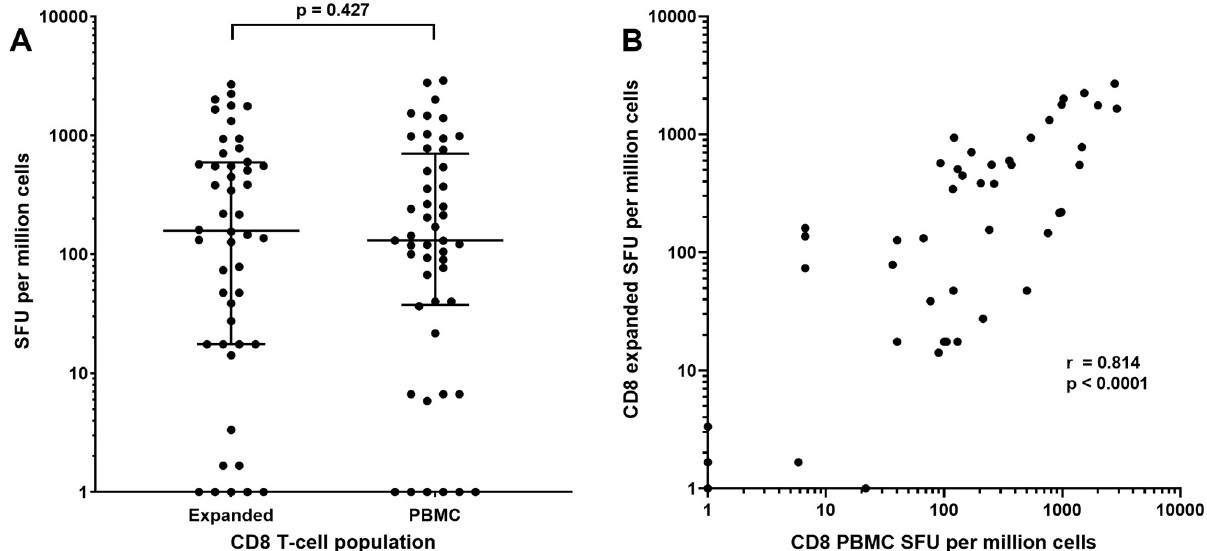
Fig 2. IFN γ ELISpot responses to CMVpp65 or HIV-1 Nef peptide pools in expanded CD8 T-cells or CD8 T-cells isolated from PBMC. A) SFU per million cells with medians (bar) and interquartile ranges and B) correlation between data sets with a non-parametric Spearman test used to compute the correlation coefficient (r) between the two the datasets. For log 10 scale display only, values of < 1 SFU were assigned a value of 1. Statistical analyses were conducted using unaltered data.